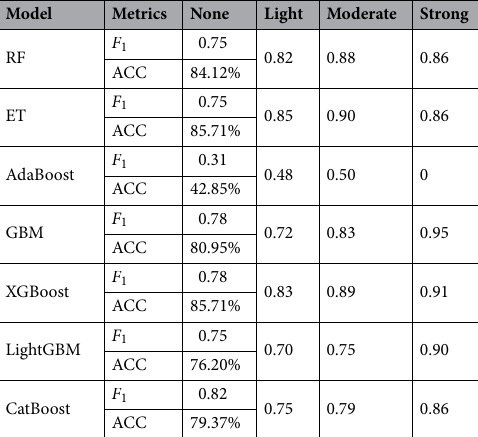
Table 10. The F 1 and accuracy in seven base models.